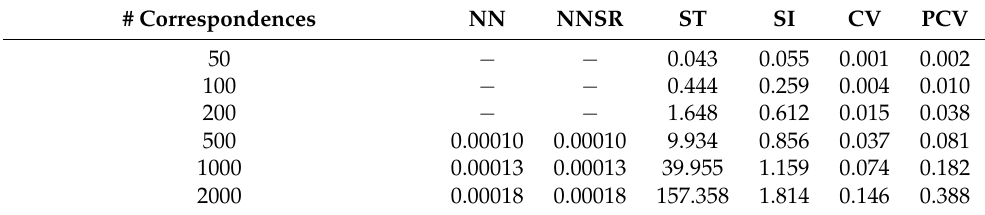
Table 4. Time costs (measured by second) of six feature matching methods respecting